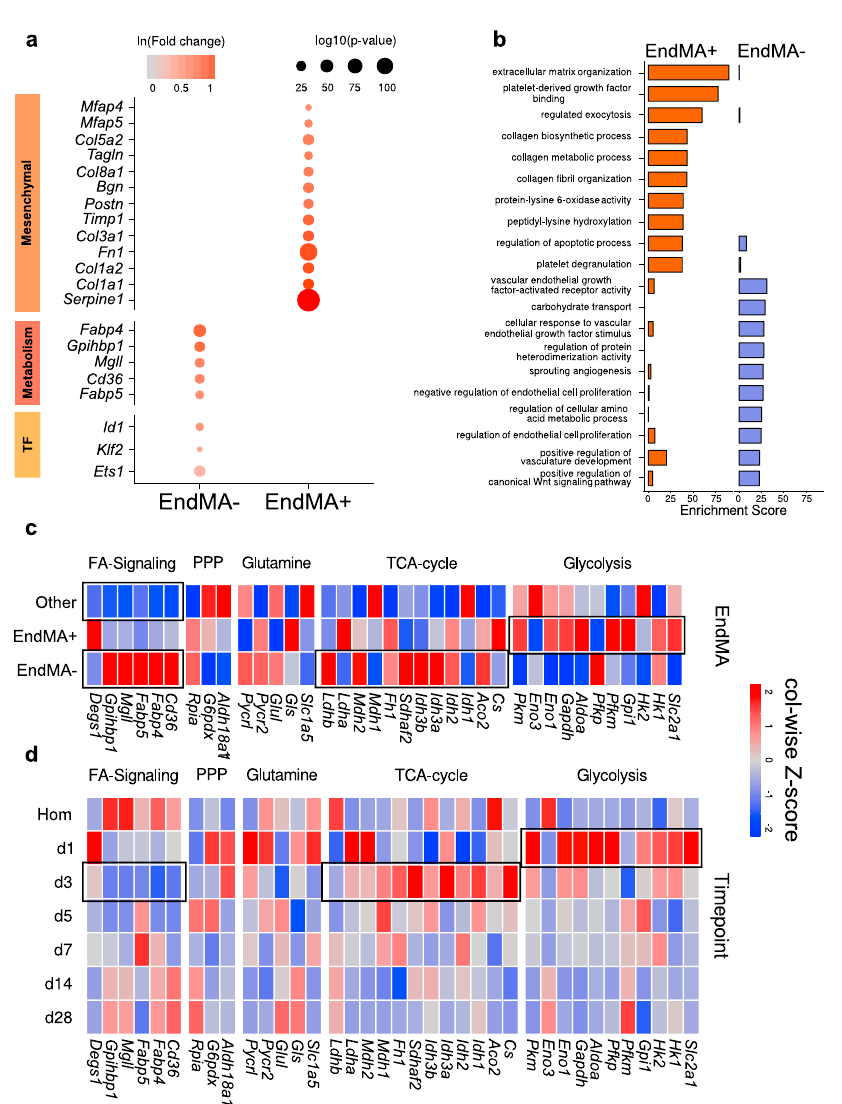
Fig. 3 Activated endothelial cells show distinct transcriptional phenotypes. a Dot plot showing signi fi cant change (Bonferroni adjusted p < 0.05) of various mesenchymal, metabolism, and transcription factor genes in Pecam1 + / Cdh5 + / Serpine1 + / Fn1 + cells (EndMA + ) compared to other endothelial cells ( Pecam1 + / Cdh5 + /mesenchymal marker - ; EndMA − ) cells. Color indicates log-fold change (red to gray), size depicts signi fi cance level (log 10 p -value). b Top 10 enriched GO-terms ranked by Enrichr ’ s combined score for genes, signi fi cantly upregulated in EndMA + and EndMA − , respectively. c , d Heatmap showing gene regulation of genes associated with fatty acid (FA) signaling, pentose phosphate pathways (PPP), glutamine metabolism, tricarboxylic acid (TCA) cycle and glycolysis pathway comparing EndMA + , and EndMA − and all other cells in the dataset ( c ) at the indicated time points in endothelial cells ( d ). Data is presented in row-wise z